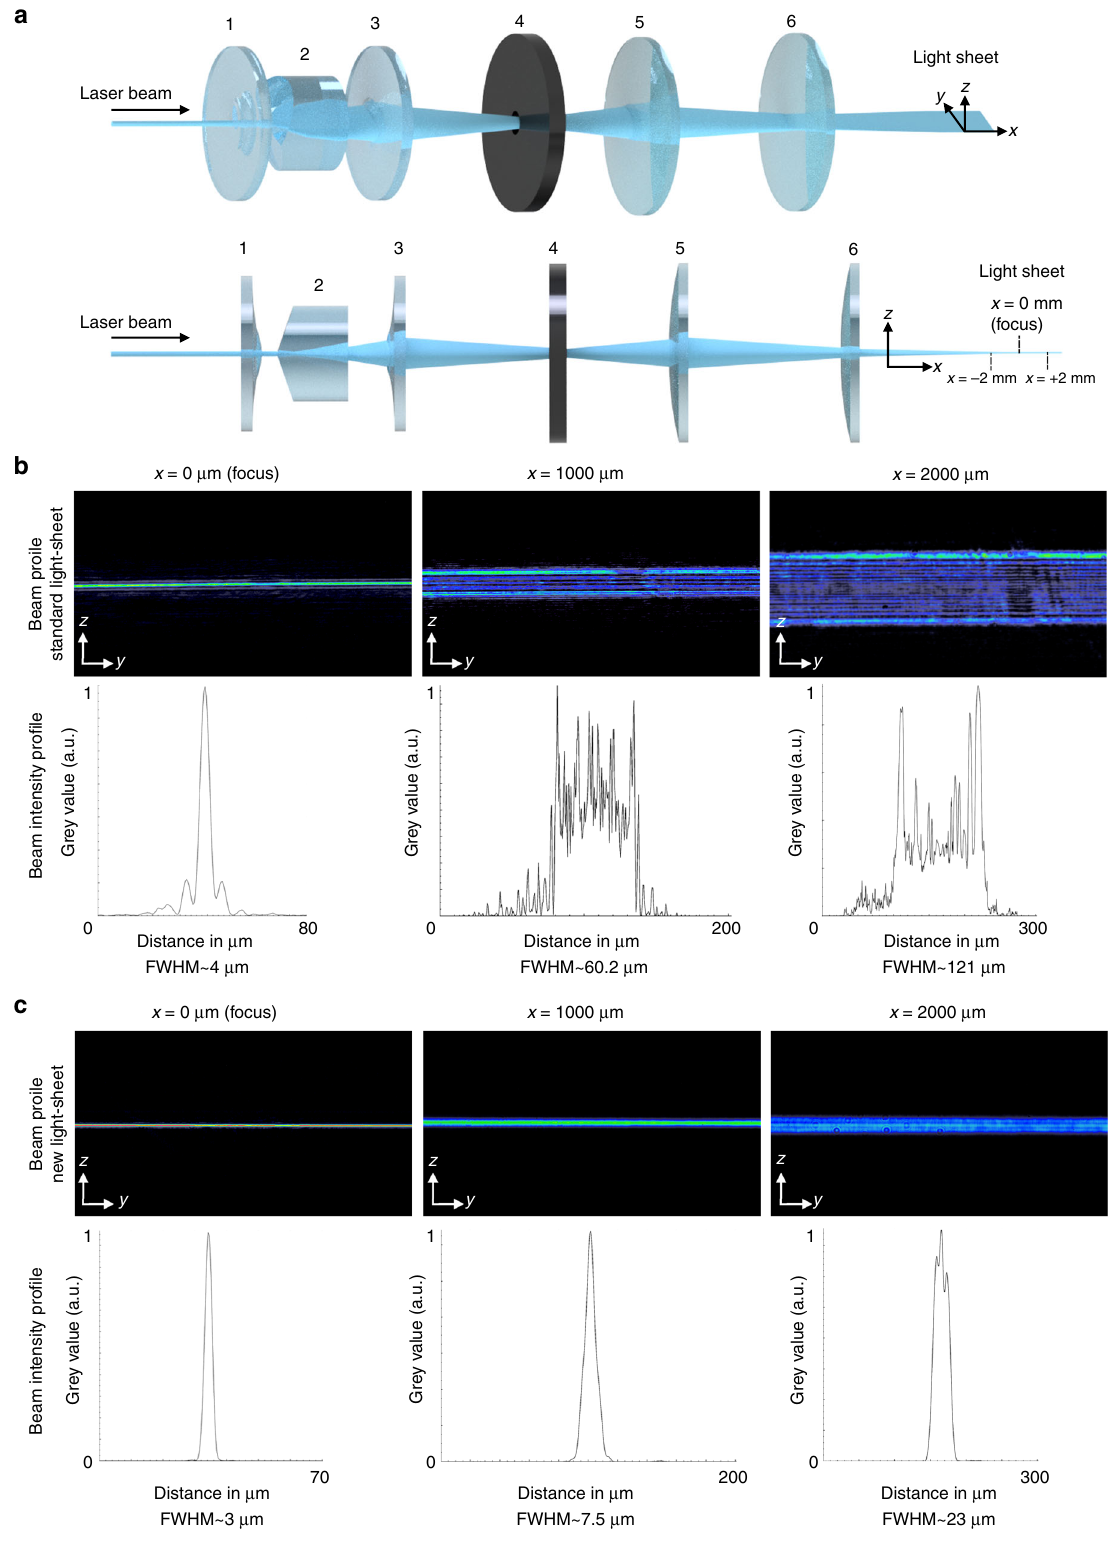
Fig. 2 Characterisation of the improved aspheric ultramicroscope system. a Illustration of the shaping of the laser beam to a light-sheet by the optimised optical unit containing complex optical components. Plano-convex aspheric cylinder lenses (1, 3), Powell lens (2), an elliptical soft-aperture (4) and Acylinder lenses (5, 6). b , c Difference between the intensity distributions across the z-y plane measured at the position x on the light-sheet by LaserCam- HRTM. Standard ultramicroscope with a 8 mm-wide slit aperture ( b ) and the aspheric ultramicroscope system optimised with a soft-aperture ( c ) measured at the focus x = 0, x = 1000 µ m and x = 2000 µ